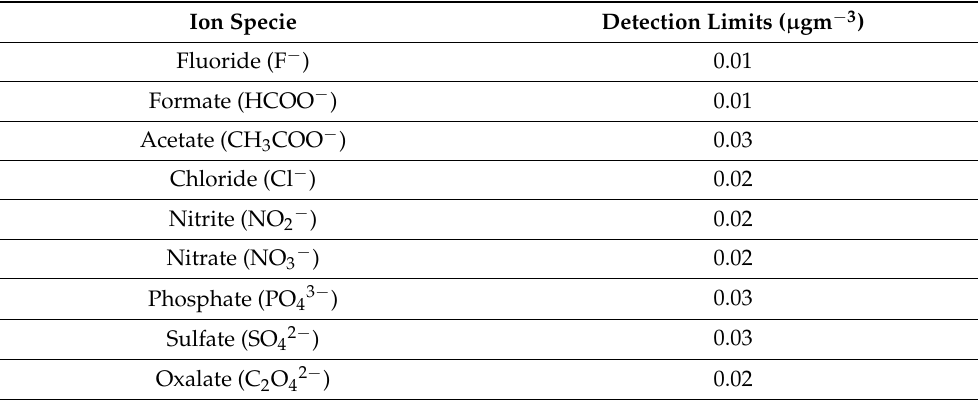
Table 3. Detection limits for the analyzed ions in PM 10